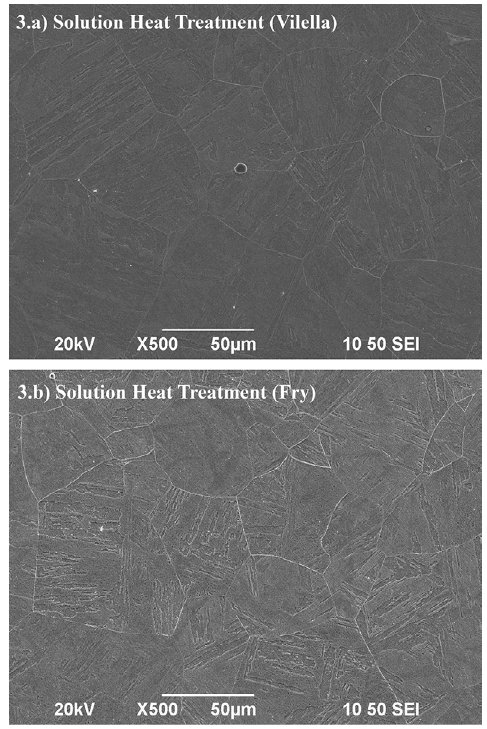
Figure 5. SEM images of H1000, etched with: (a) Vilella and (b) Fry.